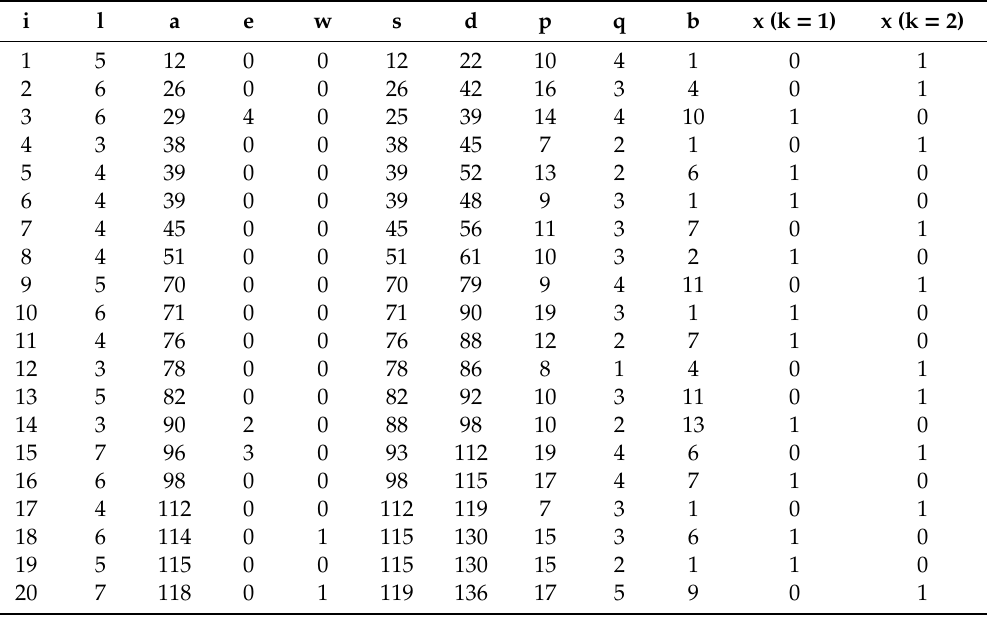
Table A3. Results of the integrated BAP and QCAP solution for Case 1: seed = 400, λ = 3.2, Z (cid:48) =